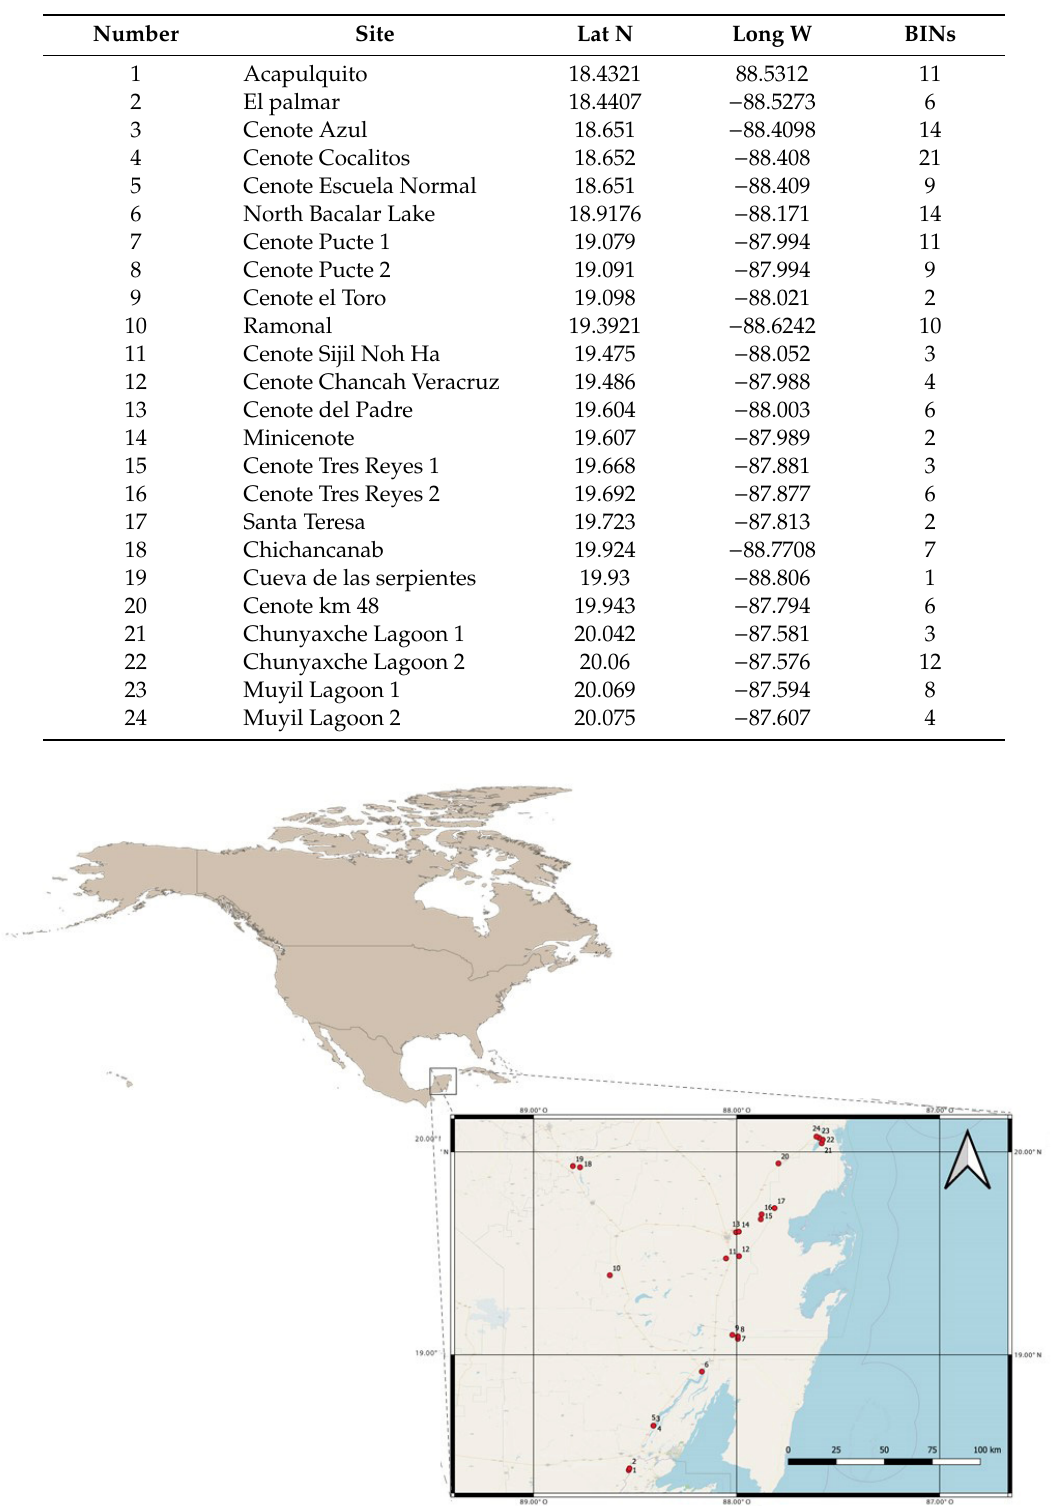
Figure 1. Location of the studied karstic systems. Names and coordinates for each site are in Table 1.